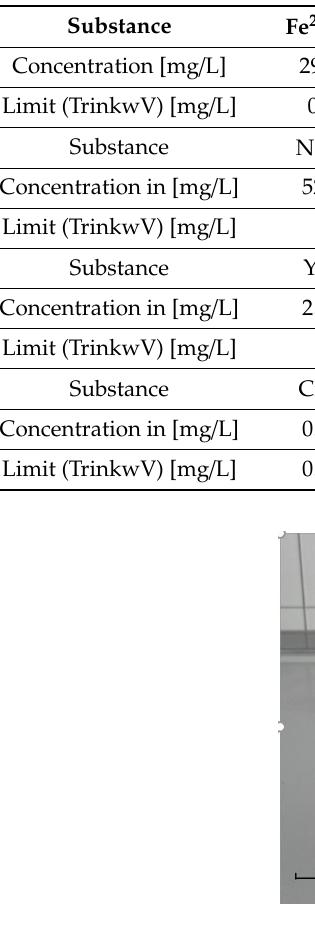
Figure 1. Mine drainage water from South Africa. Table 1. Metal containing wastewater (three significant figures).